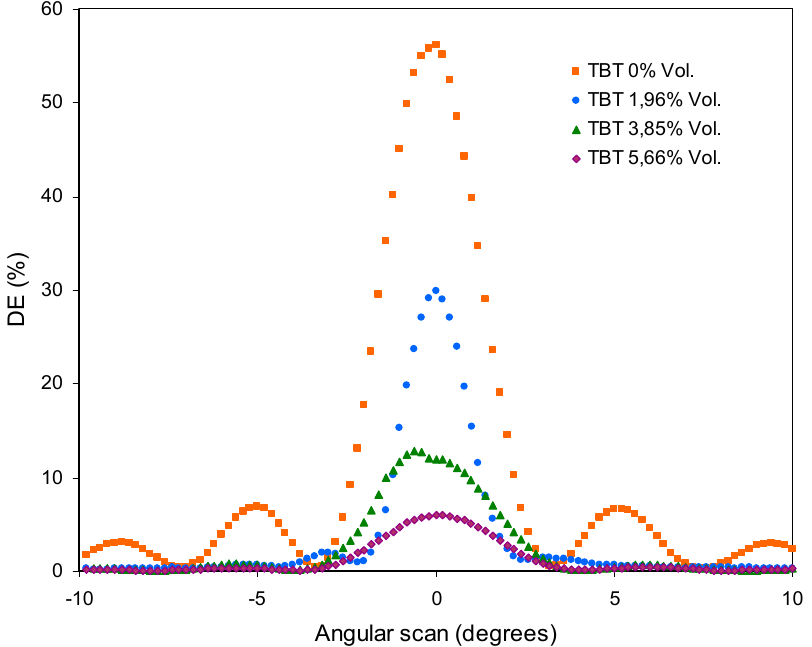
Figure 9. Diffraction efficiency versus angular scan for samples with polymer B and different concentrations of TBT.